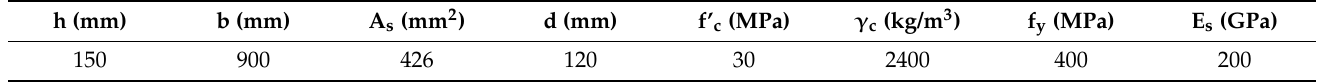
Table 2. Dimensions and material properties of the existing RC